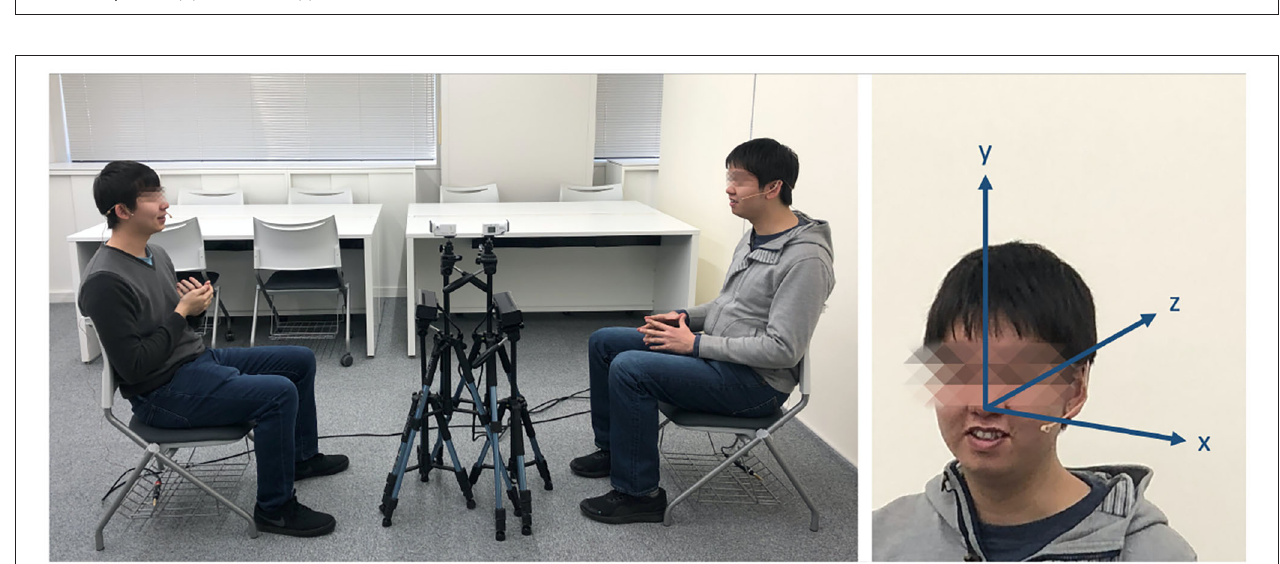
FIGURE 2 | Photograph of two-party dialogue (left) and coordinate system of the head